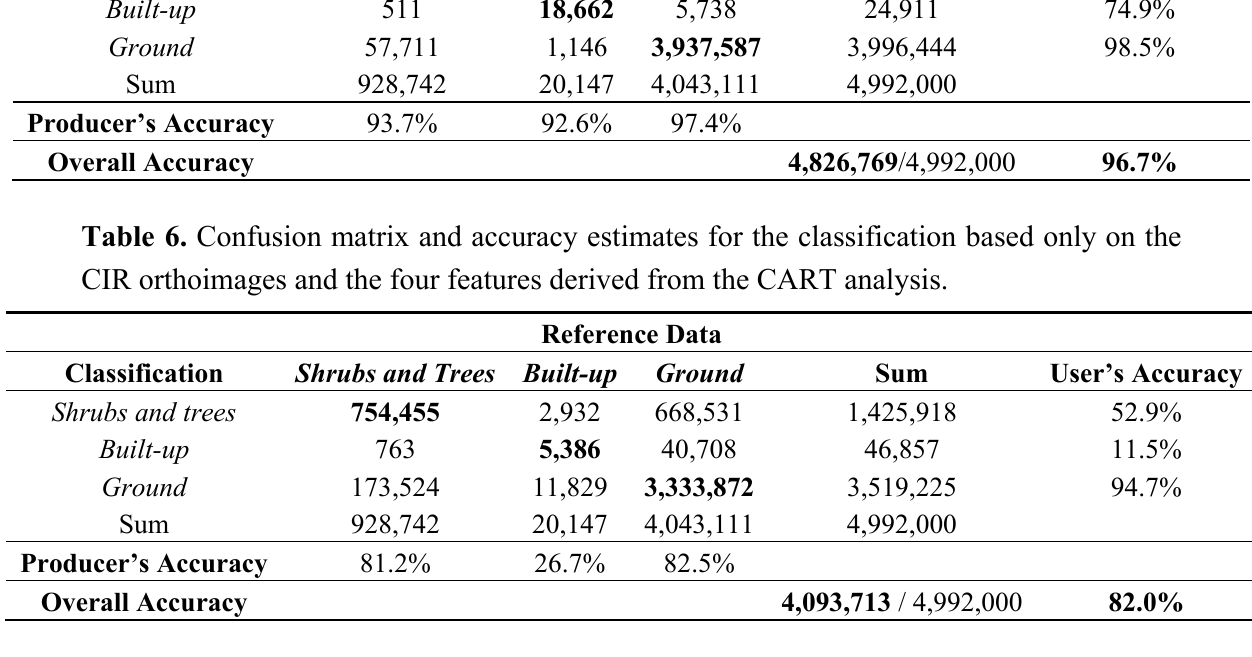
Figure 11. Result of the classification based on the nDSM and CIR orthoimages and the feature SUM/NIR derived from the CART analysis. The marked squares outlined in black demarcate the examples shown in Figures